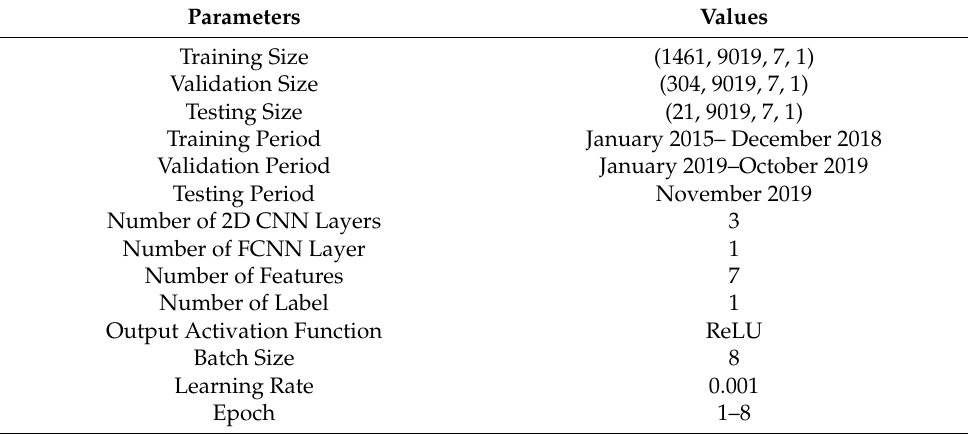
Table 4. Simulation parameters for the training model.